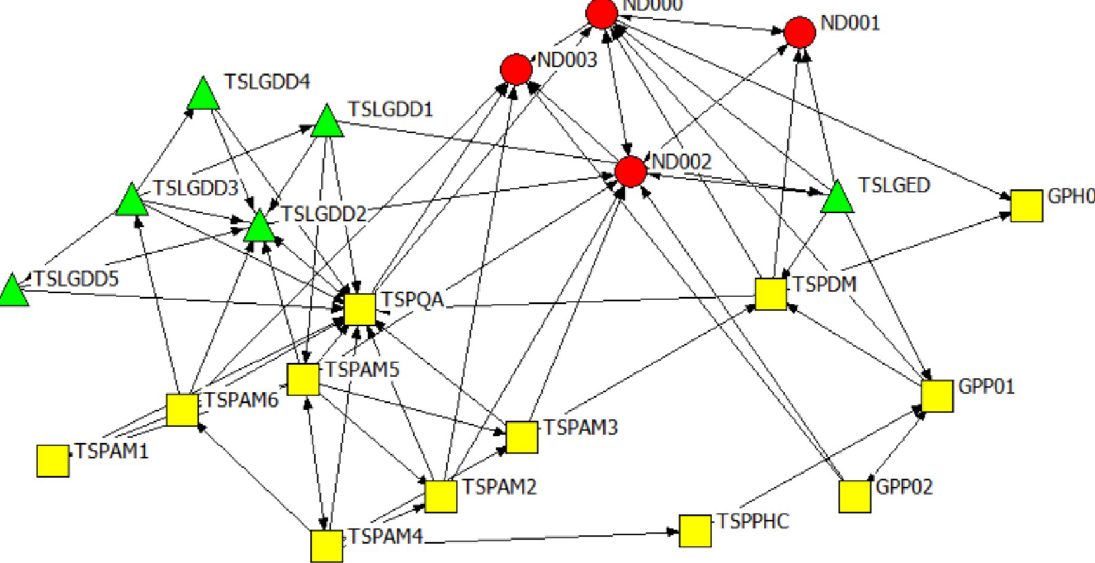
Fig 3. Gauteng province network: Seeking advice. Colour and Shape of nodes: red circle = National, yellow square = Provincial, and green triangle = Local Government. Nodes labels: ND = A label starting with TSP or GP refers to a provincial actor, TSLG = A label starting with TSLG refer to a local government